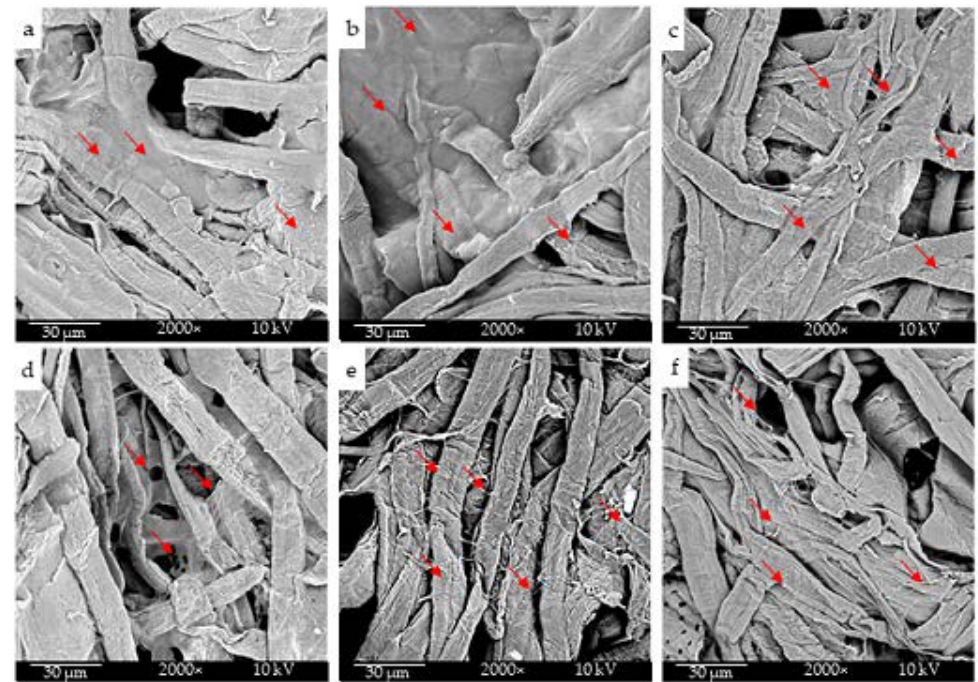
Figure 7. Direct cytotoxicity test: SEM analysis performed on HaCaT cells cultured on cellulose tissues electrosprayed with: ( a ) sCNs (water); ( b ) sCNs (water/acetic acid); ( c ) sCNs (water/HFlP); ( d ) mCNs (water); ( e ) mCNs (water/acetic acid). ( f ) Pristine cellulose tissue. Some dense cell-populated areas are indicated by red arrows. Original magnification 2000 × .